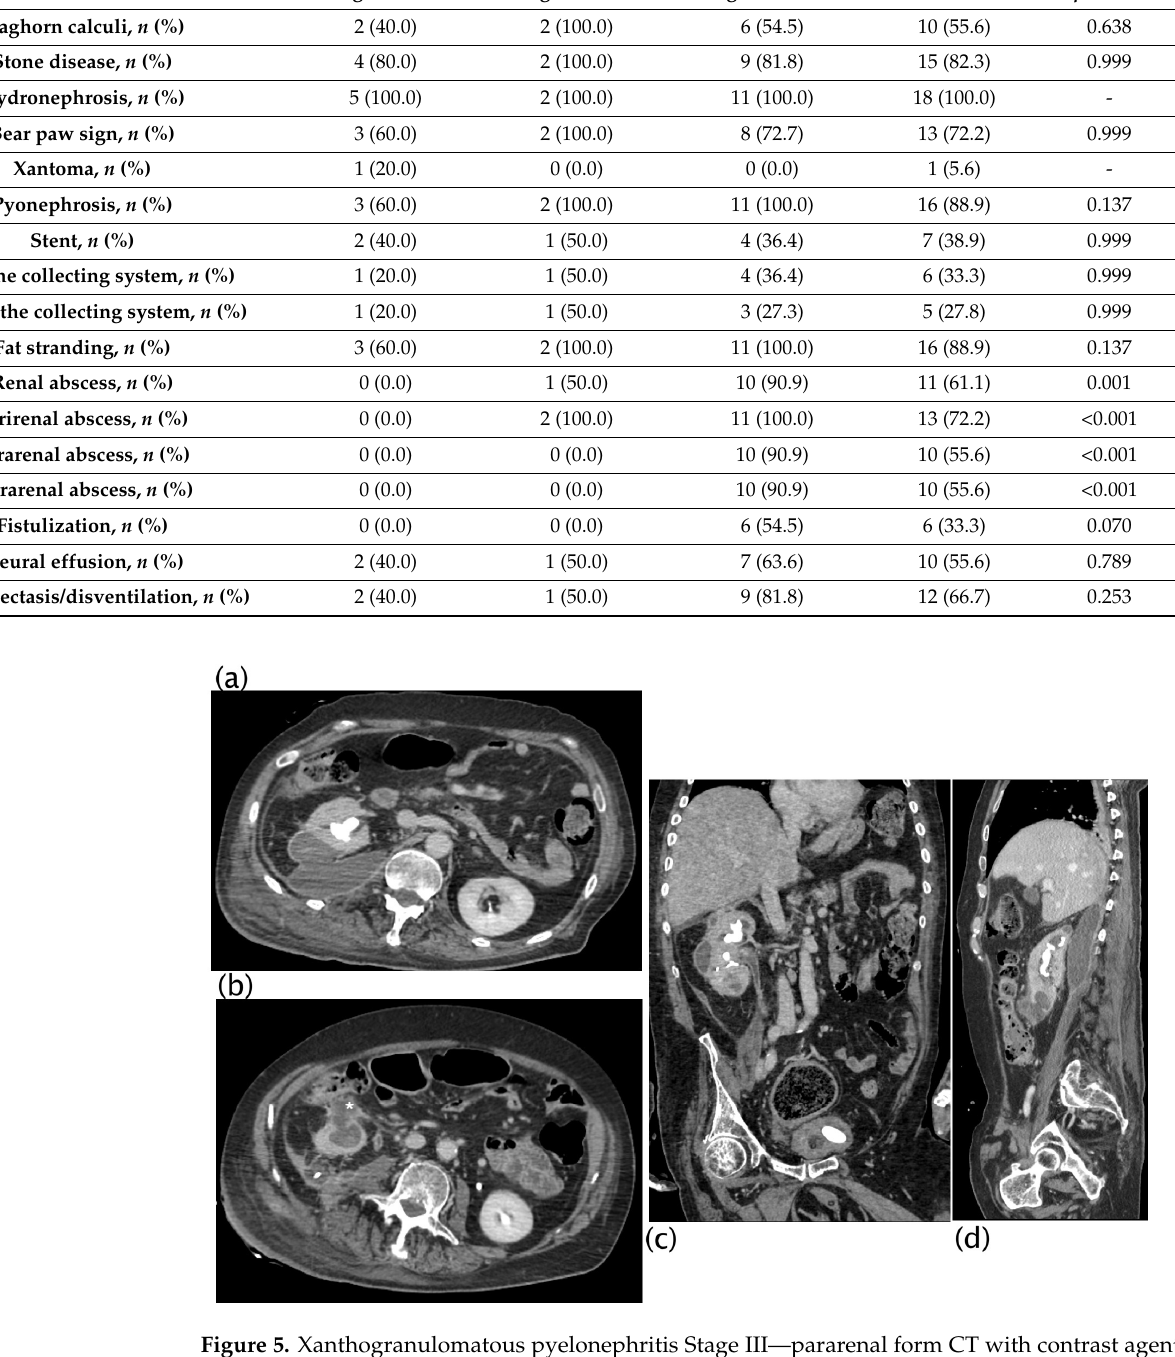
Figure 5. Xanthogranulomatous pyelonephritis Stage III—pararenal form CT with contrast agent: axial ( a , b ), coronal ( c ), and sagittal ( d ) MPR reconstruction. In the right kidney, staghorn lithiasis is present; gross vesical lithiasis is also visible. The walls of the ureter are thickened and hyperemic. The CT was performed after nephrostomy placement, so significant calico-pyelic dilatation is not significant. Peri- and pararenal collections are evident, particularly the inferior polar collection ( c ) that passes the perirenal fascia. Posteriorly ( b ), the inflammatory process passes and infiltrates the psoas muscle. The staghorn lithiasis, the coexistence of calico-pyelic dilatation and fluid collections, and especially, the high invasiveness of the pathology, allowed, with high diagnostic confidence, to make the diagnosis of XGP.